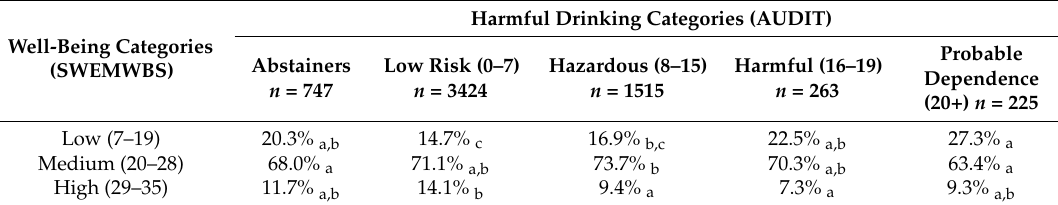
Table 3. Proportion of each harmful drinking category that fall into each well-being category.